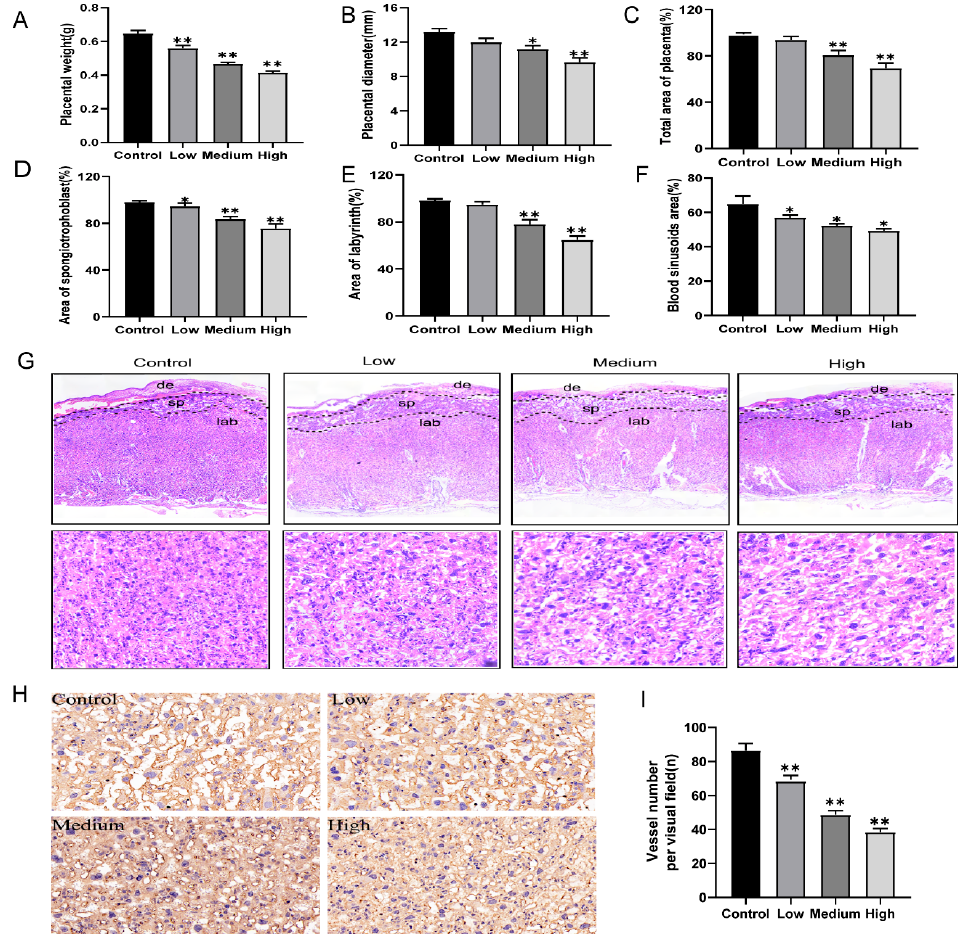
Figure 2. Gestational exposure to cyfluthrin impairs placental development. Pregnant rats were administered corn oil or different doses of cyfluthrin (6.25, 12.5, or 25 mg/kg) daily in pregnancy. Rat placentas were collected on GD19. ( A ) Average placental weight. ( B ) Average placental diameter. ( C ) Total area of placenta(%). ( D ) Area of spongiotrophoblast(%). ( E ) Area of labyrinth(%). ( F ) Blood sinusoid areas in the labyrinthine layer were estimated from five nonconsecutive sections in each placenta. ( G ) Images of placental cross sections, which were stained with H&E. Images of blood sinusoid areas in the placental labyrinthine region. Original magnification: 40×. ( H ) Placental CD34 expression was detected using immunohistochemistry. Representative images were chosen from the placental labyrinth. Original magnification: 40×. ( I ) CD34-positive vessels were counted per visual field. Values are expressed as the mean ± SE. The result was analyzed with one-way ANOVA followed by Dunnet’s t -test. * P < 0.05, ** P < 0.01 compared to